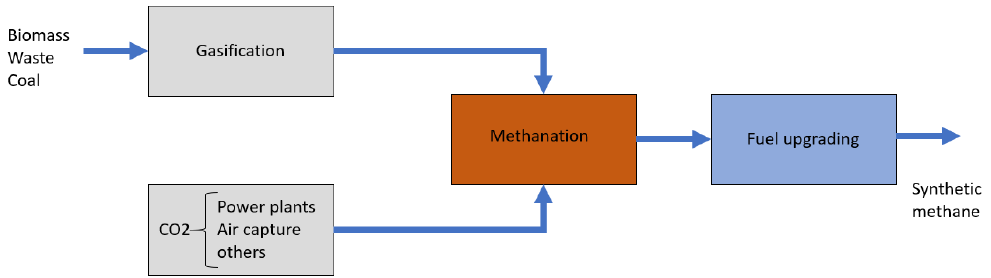
Figure 1. Methanation